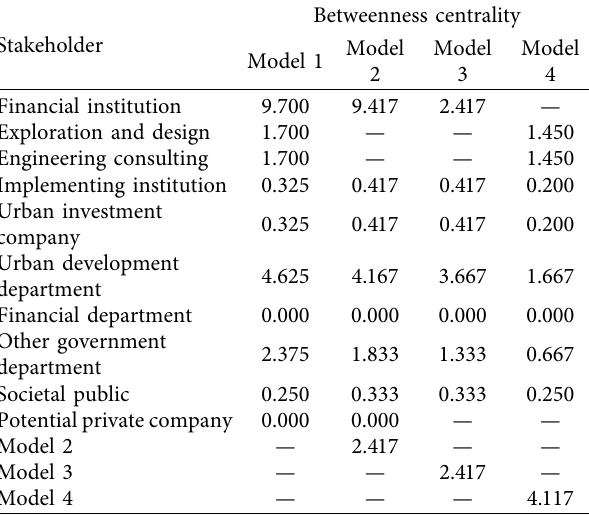
Table 9: Index of betweenness